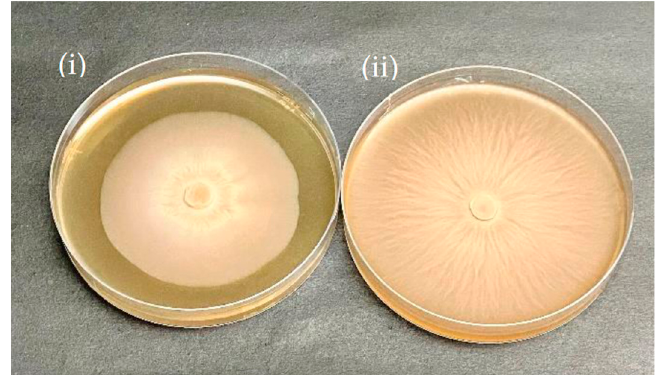
Figure 5. The growth enhancement of P. indica when treated with silver nanoparticles in 4% jaggery broth media prepared at pH 6.7: ( a ) Top view, ( b ) front view. Note: (i) Control, (ii) 100 ppm, (iii) 200 ppm, (iv) 300 ppm, and (v) 400 ppm. Growth retardation was observed in higher concentrations (400 ppm) of AgNPs.